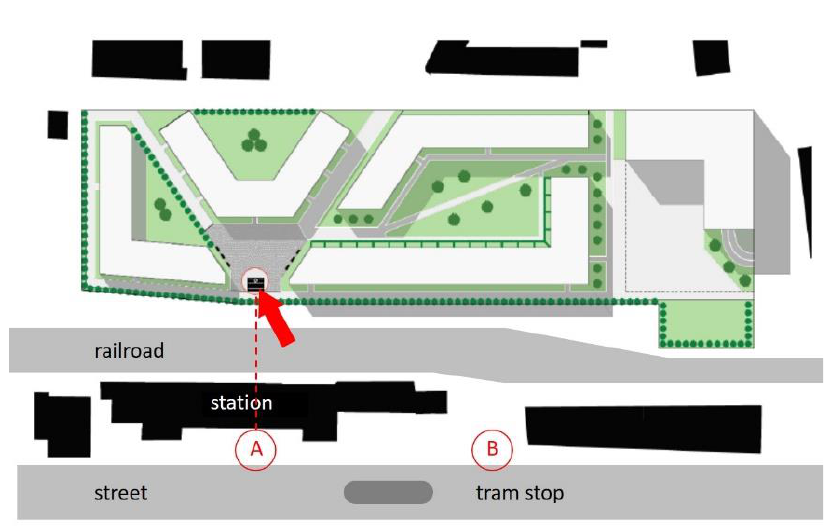
Fig. 1 Location plan of planning